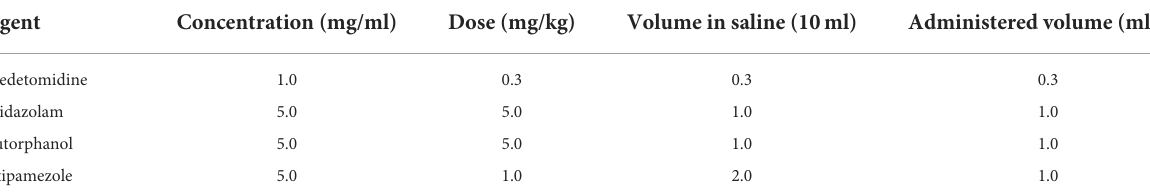
TABLE 1 Concentrations and doses of the used anesthetic agents.